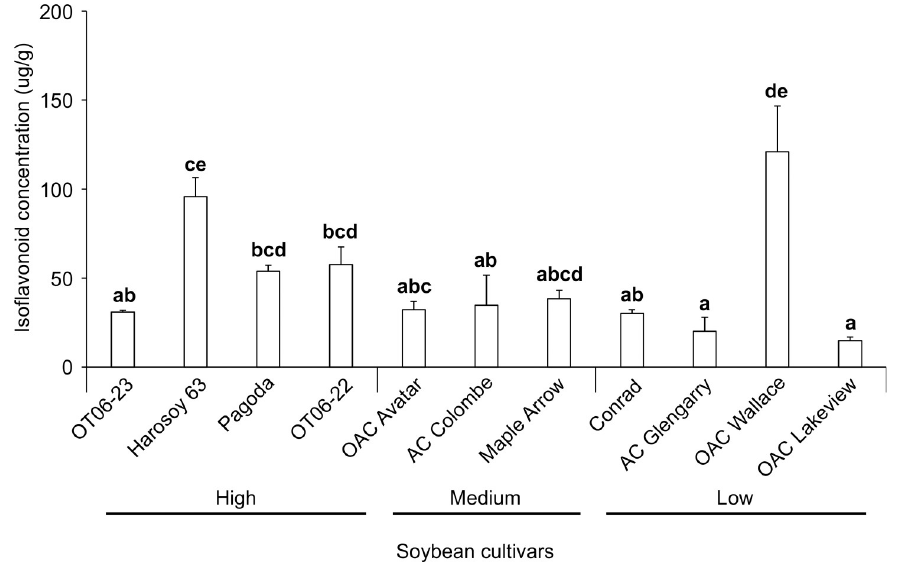
Fig 5. The effect of two-spotted spider mite feeding on total isoflavonoid concentrations in the top 3 trifoliate leaves of 11 soybean cultivars after 4 weeks. Data are mean ( ± S.E.) total isoflavonoid concentrations ( μ g/g). Bars with the same letters are not statistically different (Kruskal-Wallis, P >